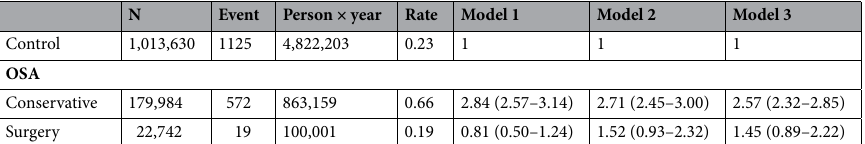
Table 3. Hazard ratio for Parkinson’s disease in patients with OSA. Model 1: not adjusted/Model 2: adjusted by age and sex/. Model 3: adjusted by age, sex, income level, diabetes, hypertension, and dyslipidemia/. OSA obstructive sleep